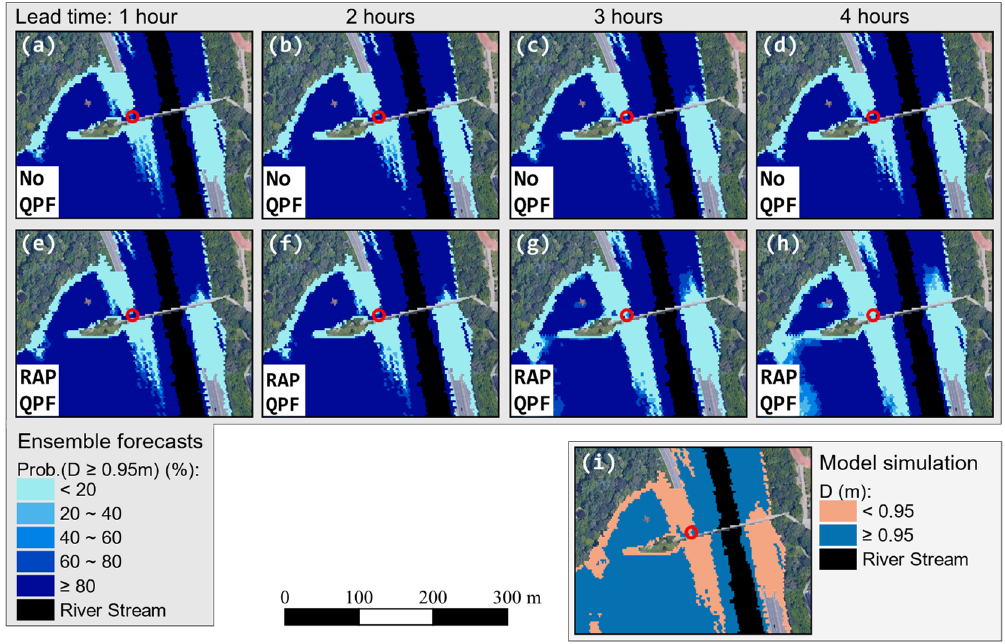
Figure 13. ( a – i ) Same as Figure 12, but for the POI 2 (red circle in the maps).